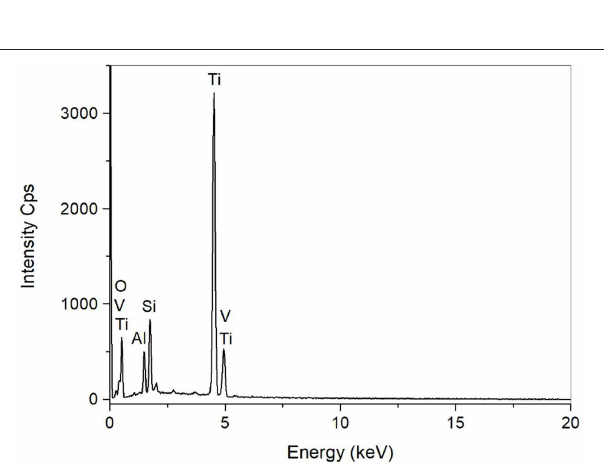
tribochemical products of SiO 2 and TiO 2 . So, it can be concluded